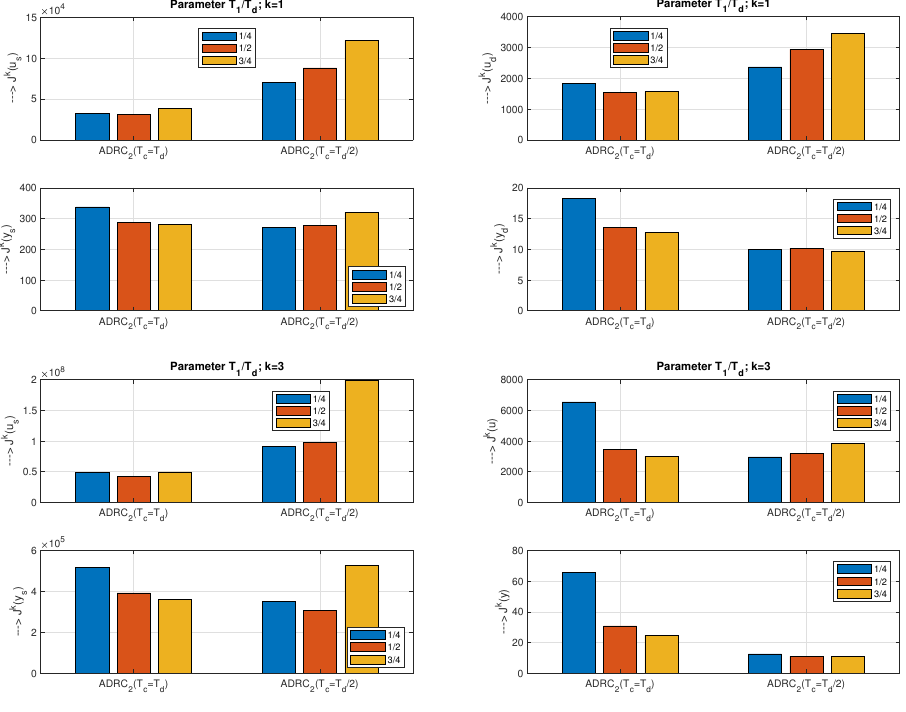
Figure 13. ADRC 2 controllers for T 1 / T d = { 0.5,1,2 } with T dm = T d − T 1 , T c = T d and T c = T d /2: Holistic cost functions (45) and (46) characterizing performance at the plant input and output for both setpoint and disturbance steps with k = 1 and k =